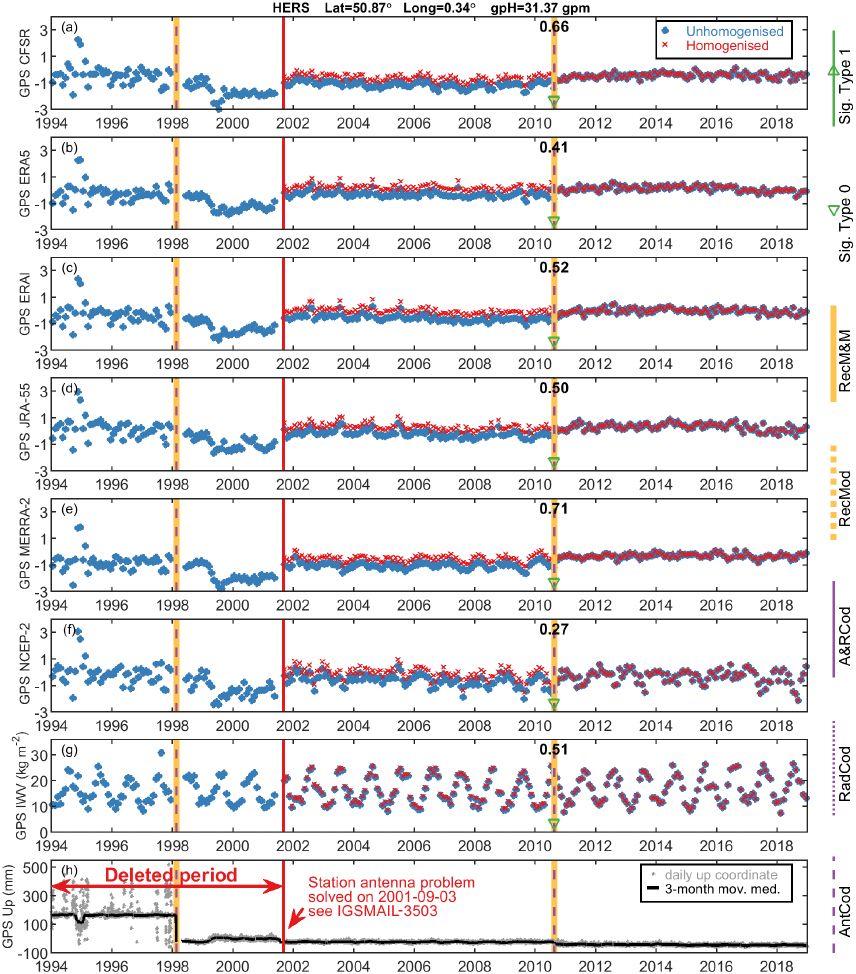
Figure A1. Monthly GPS-reanalysis IWV difference (a–f) , monthly GPS IWV (g) , and daily up-coordinate time series at station HERS. The GPS data before 3 September 2001 were deleted due to a problem in station antenna (see IGSMAIL-3503). The IWV time series before and after the homogenisation are labelled as blue dots and red crosses in panels (a) – (g) . The types of instrumentation changes are listed in Table A2. The Type-0 changepoint on 19 August 2010 is significant at a confidence level of 99% (green downward-pointing triangle), and its value was calculated as the average of the values estimated in each GPS-reanalysis comparison as shown in panels (a) – (f)